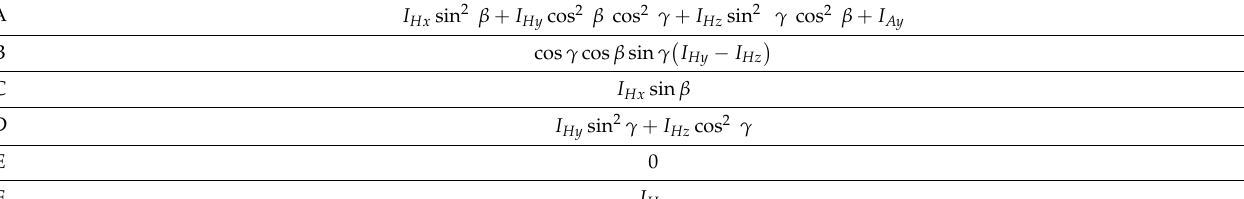
Table 4. Definition of the terms in Equation